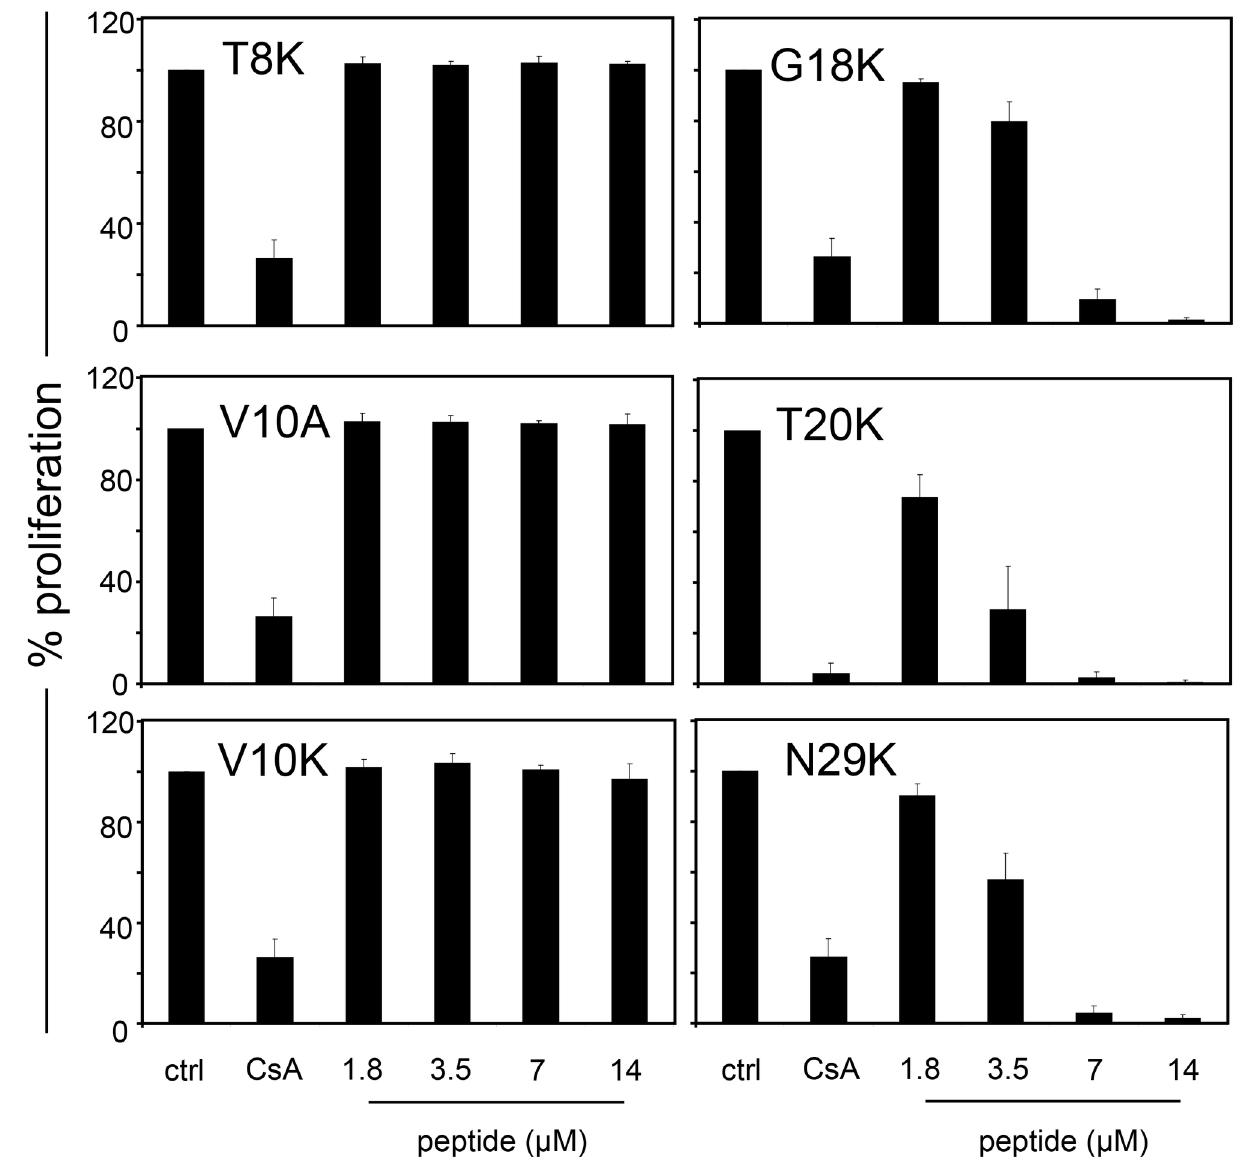
Figure 2. Effects of cyclotide mutants on cell proliferation of primary activated human lymphocytes. The influence of medium (ctrl), CsA (0.8 µM) or different concentrations of the kalata B1 cyclotide mutants [T8K], [V10A], [V10K], [G18K], [T20K] and [N29K] (1.8-14 μM) on proliferation of activated primary lymphocytes was measured by cell division analysis using CFSE-based flow cytometry on day three post stimulation. Data are presented as mean ± SD of four (three for [T20K] kalata B1) independent donors and experiments. Corresponding IC values have been presented in Table 1. 50 doi: